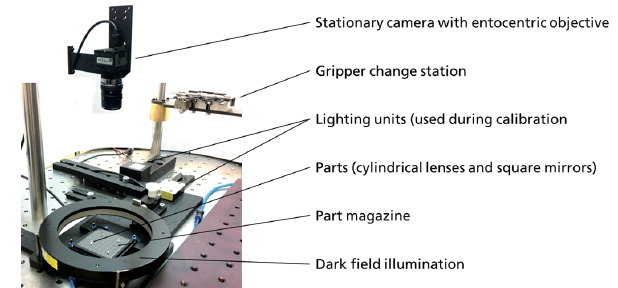
Figure 9. Setup for detecting and localizing randomly positioned optical components on a Gel-Pak ® vacuum release tray using dark field illumination (ring light).